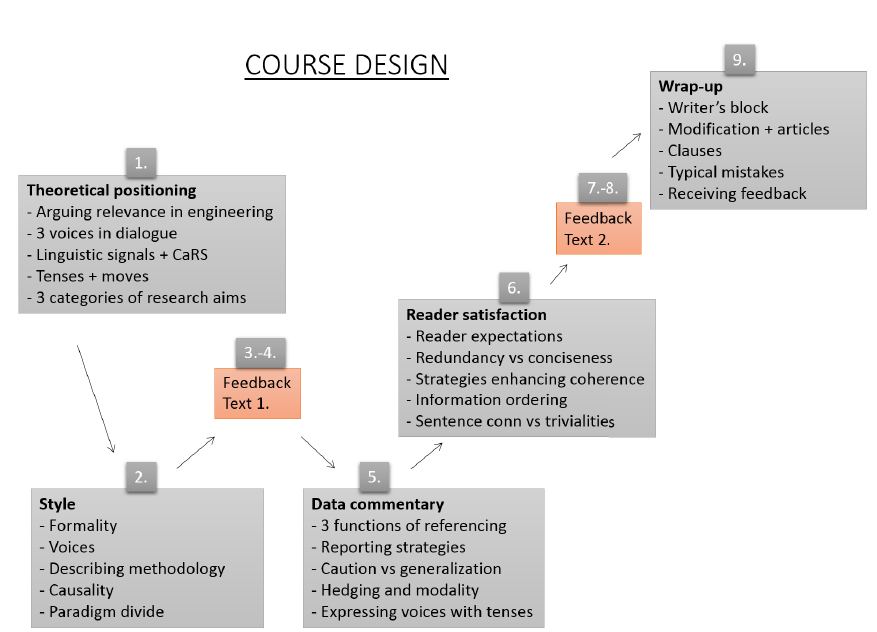
Fig. 3. Writing Doctoral Research course